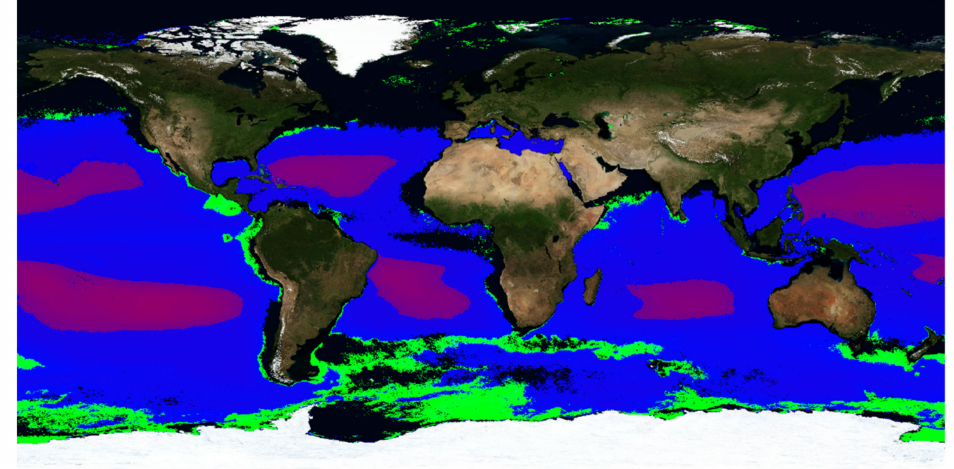
Figure 10. Different regions of global ocean based on chlorophyll concentration (purple is oligotrophic oceans, blue is open oceans, green is coastal areas, black is Case II